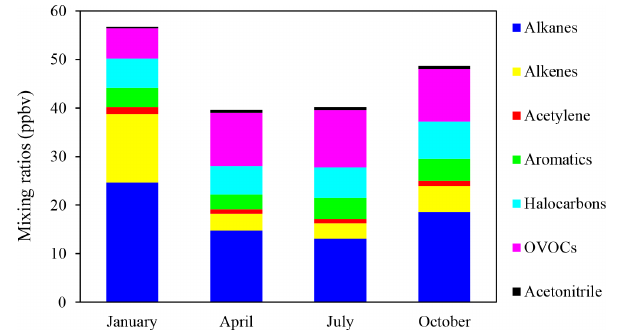
Figure 5. Mixing ratios and compositions of VOCs (ppbv) mea- sured at the PKU site during the four seasons and throughout the study